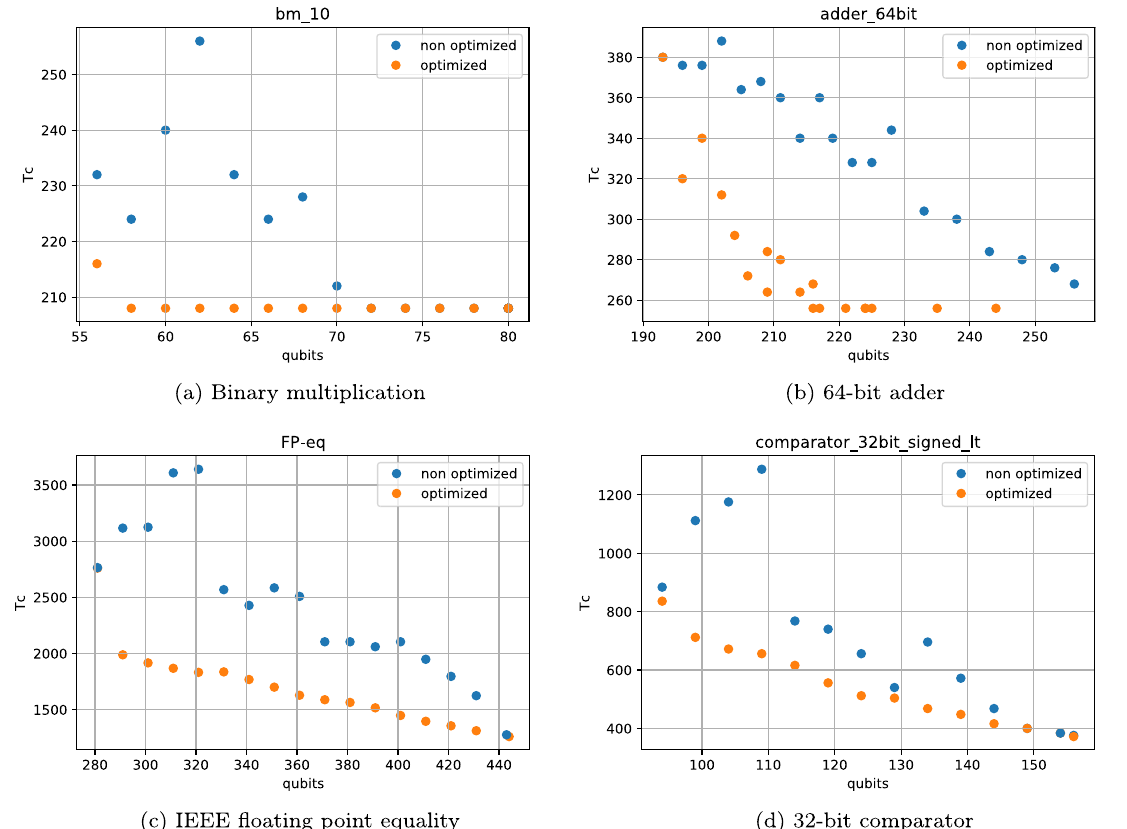
Fig. 3 Results of pebbling selected logic networks using different number of pebbles: comparison between optimized and non- optimized solutions. Results of pebbling a circuit implementing a binary multiplication; b a 64-bit addition; c IEEE fl oating point equality; d a 32-bit comparator.